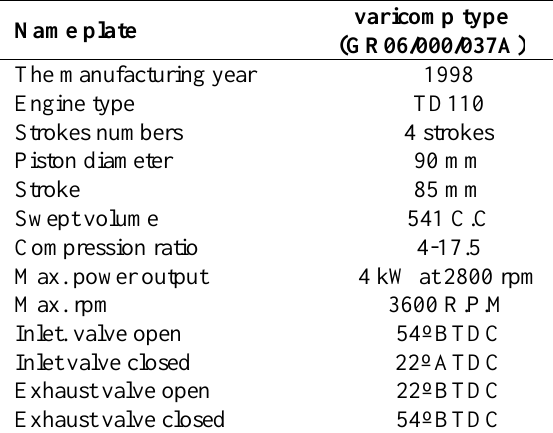
Fig. 1. The engine rig and the measuring instruments Table 1, Engine